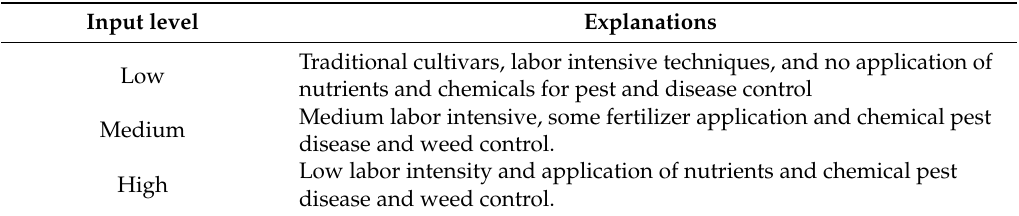
Table 2. Input level for the Global Agro-ecological Zones (GAEZ) model.